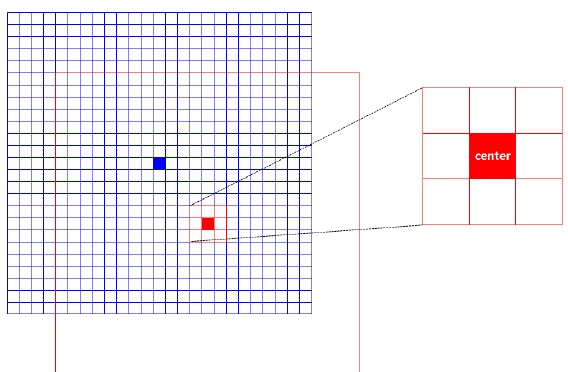
Figure 3. Example of a change in target center in the target selection process for a given target box size. The original center of 25 × 25 pixels of the blue target box moves to the new center of 3 × 3 pixels of the red nested box with the largest standard deviation of nine pixels in brightness temperature for SWIR, IR, and WV or albedo for VIS.